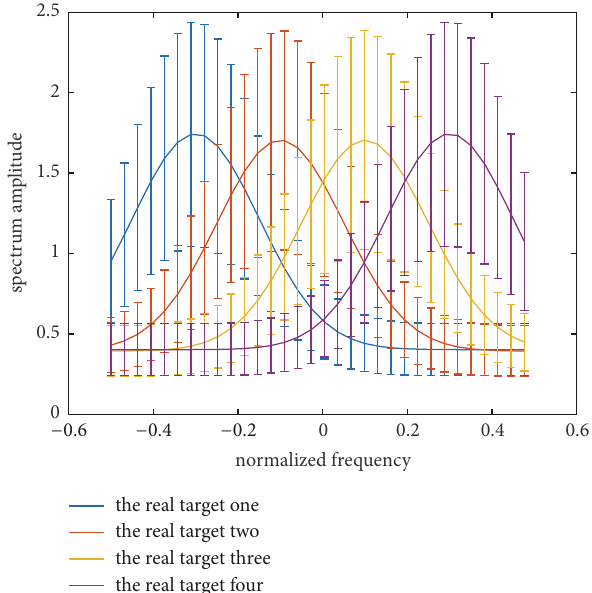
Figure 3: Model of the uncertainty range of multitarget